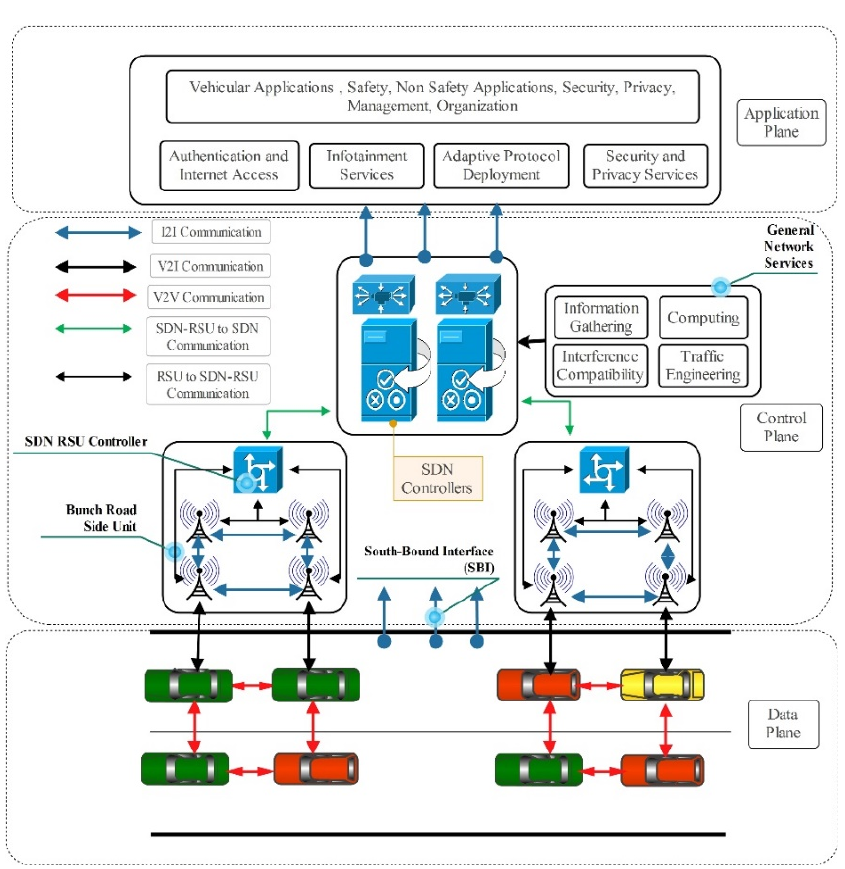
Figure 9. SDN-based vehicular ad-hoc networks architecture.